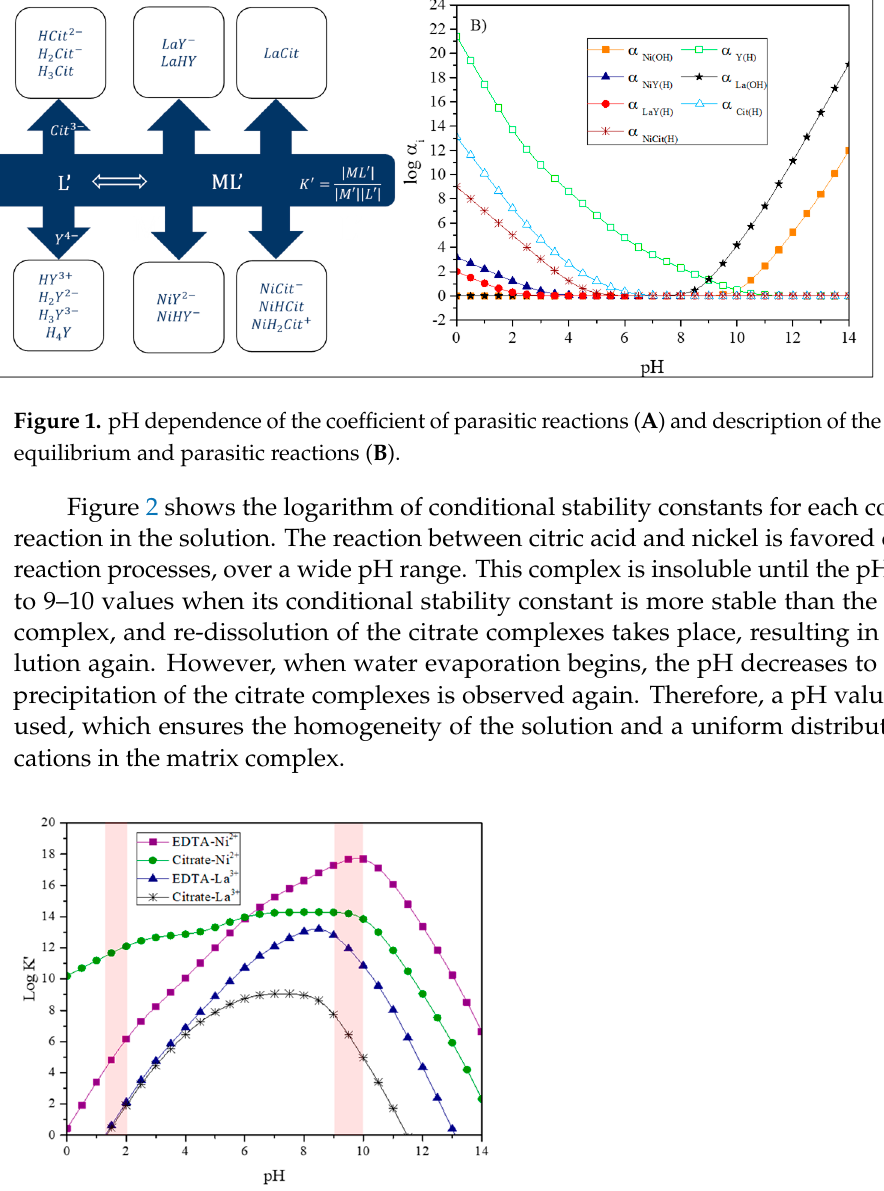
Figure 2. Conditional stability constants of the La and Ni against EDTA and citrates complexes at different pH values.